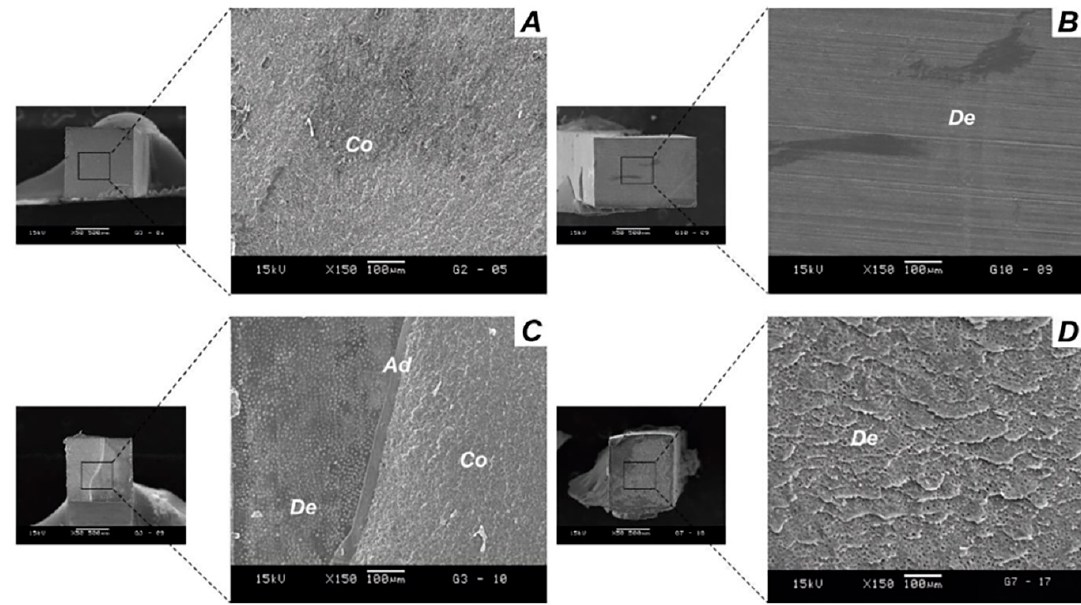
Figure 4. SEM image of failure modes. ( A ) Cohesive failure in Resin Composite; ( B ) Adhesive failure; ( C ) Mixed failure and ( D ) Cohesive failure in Dentin. Abbreviations shows areas of Co . Composite; Ad . Adhesive; De . Dentin.